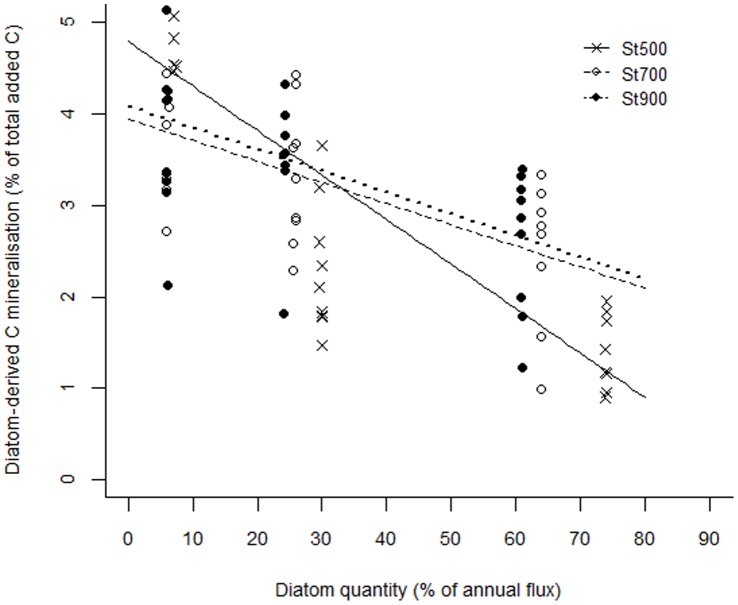
Reduction in diatom-derived C mineralisation efficiency with increasing substrate quantity.Mineralised diatom C is expressed as the percentage of total diatom C added.